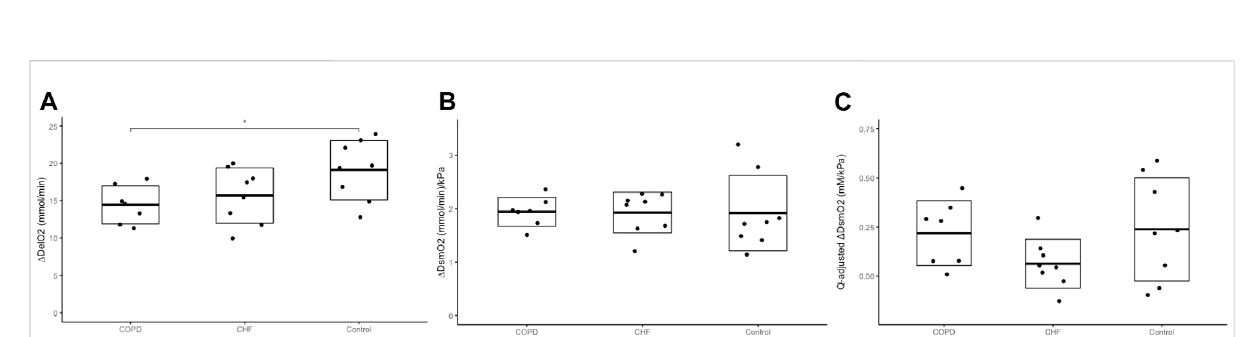
FIGURE 3 Skeletal muscle oxygen delivery and conductance Panel (A) shows the change ( Δ ) in O 2 delivery ( Δ DelO 2 ) from rest to one leg knee-extensor exercise at 10 W, panel (B) change in skeletal muscle oxygen conductance (D SM O 2 ) and panel (C) change in fl ow adjusted skeletal muscle oxygen conductance (Q _ -adjusted D SM O 2 ). We performed a one-way ANOVA and if signi fi cant, a Tukey ’ s honest signi fi cant difference test was used to analysethedifferencesbetweengroups.Differencebetweengroupsmarkedwitha*=( p < 0.05)and**=( p < 0.01).Dotplotswithboxesshowing mean and standard deviation with exact values for each participant, marked with a black dot. Chronic heart failure (CHF) participants n = 8, Chronic obstructive pulmonary disease (COPD) participants n = 7, healthy control n =